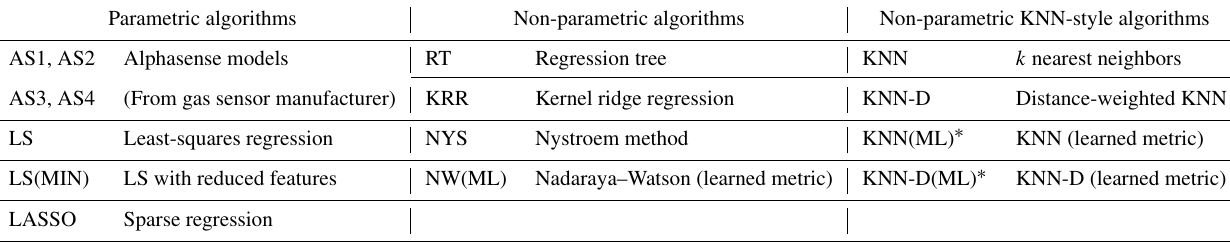
Table 2. Glossary of baseline and proposed calibration algorithms used in our study with their acronyms and brief descriptions. The KNN(ML) and KNN-D(ML) algorithms are proposed in this paper. Please see the Supplement for details.